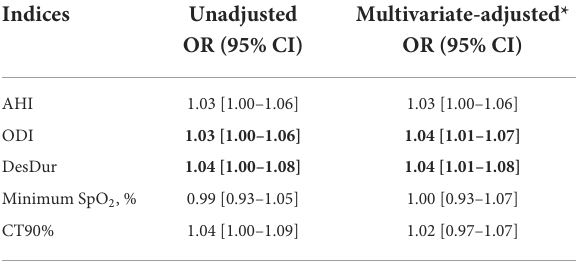
TABLE 3 Association of AHI and oxygen desaturation indices with total CSVD score ( n = 85).